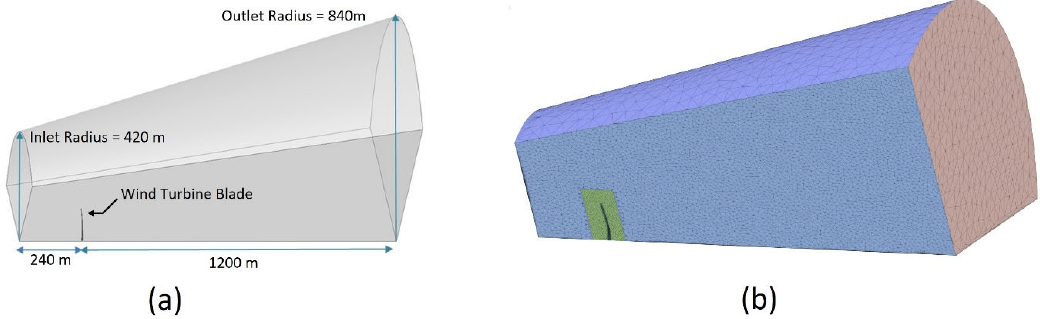
Figure 4. ( a ) CFD conical domain and ( b ) mesh domain representation for the CFD simulation.